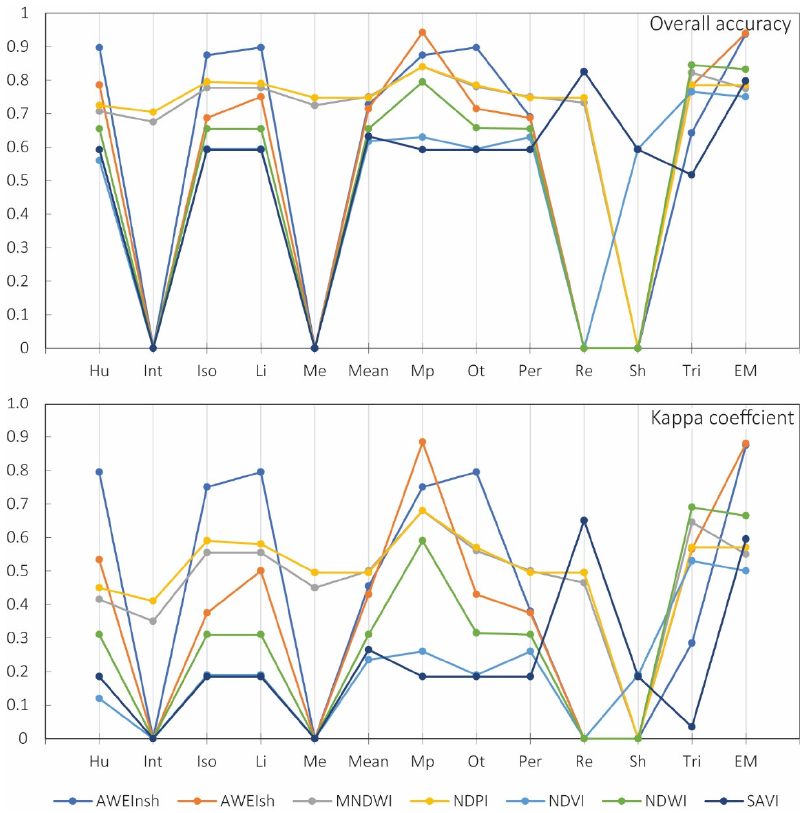
Figure 9. Accuracy values plotted for each index and mapping method by Overall and Kappa algorithms.